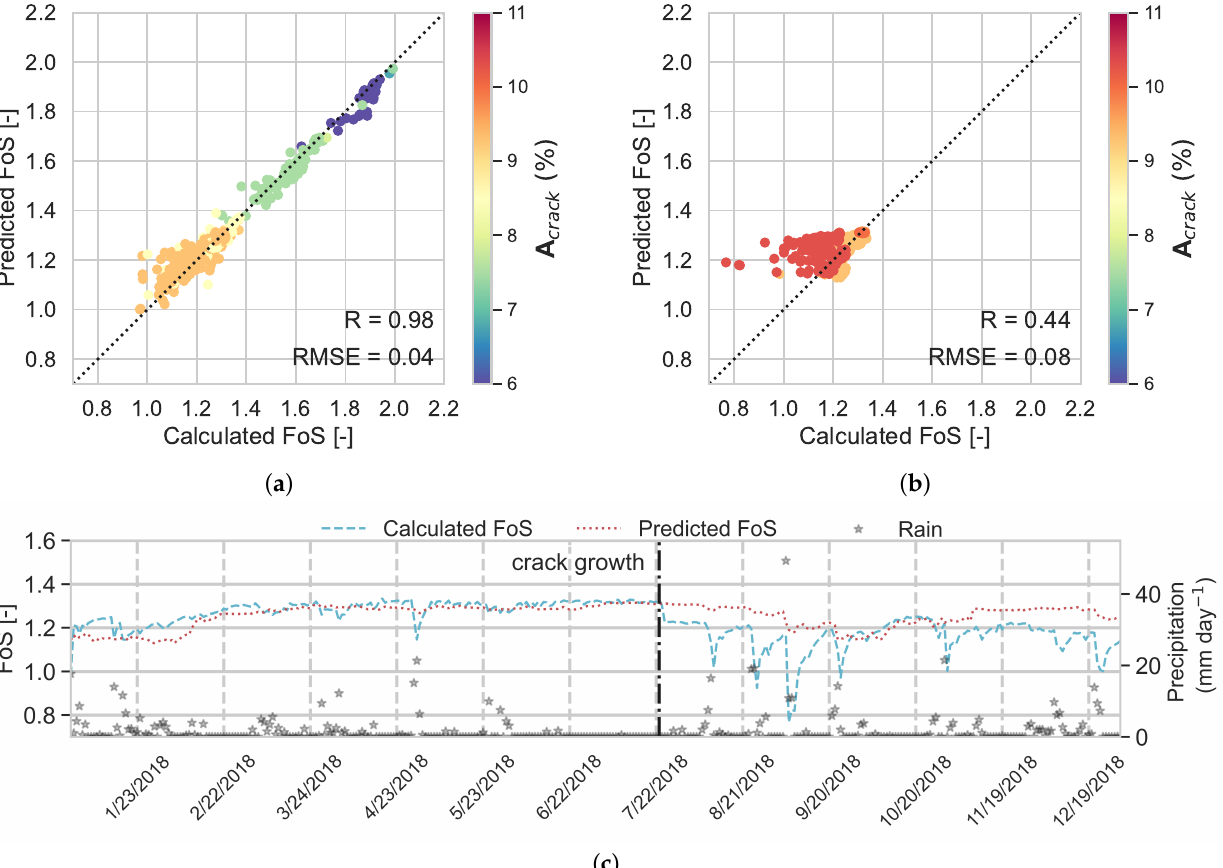
Figure 13. RF stp ,15 d , Acr model performance, over ( a ) the testing data set and ( b ) the independent data set, and ( c ) time series of predicted and calculated FoS in the evaluation data set (year